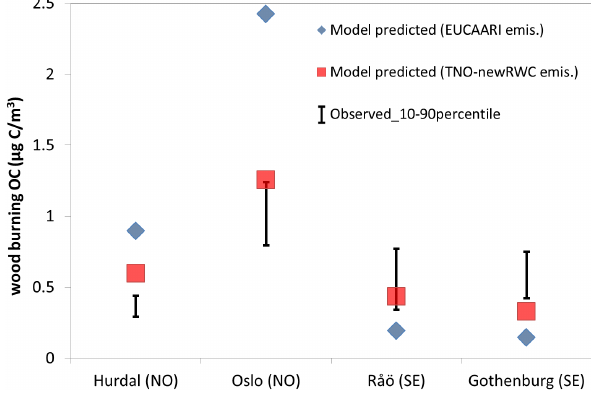
Figure 10. Comparison of model calculated OC (µg(C) m − 3 ) from wood burning (residential combustion + open vegetation fires) to source-apportionment data from measurement campaigns during winter in Norway (SORGA, 1–8 March 2007, Yttri et al., 2011) and Sweden (GÖTE, 11 February–4 March 2005, Szidat et al.,